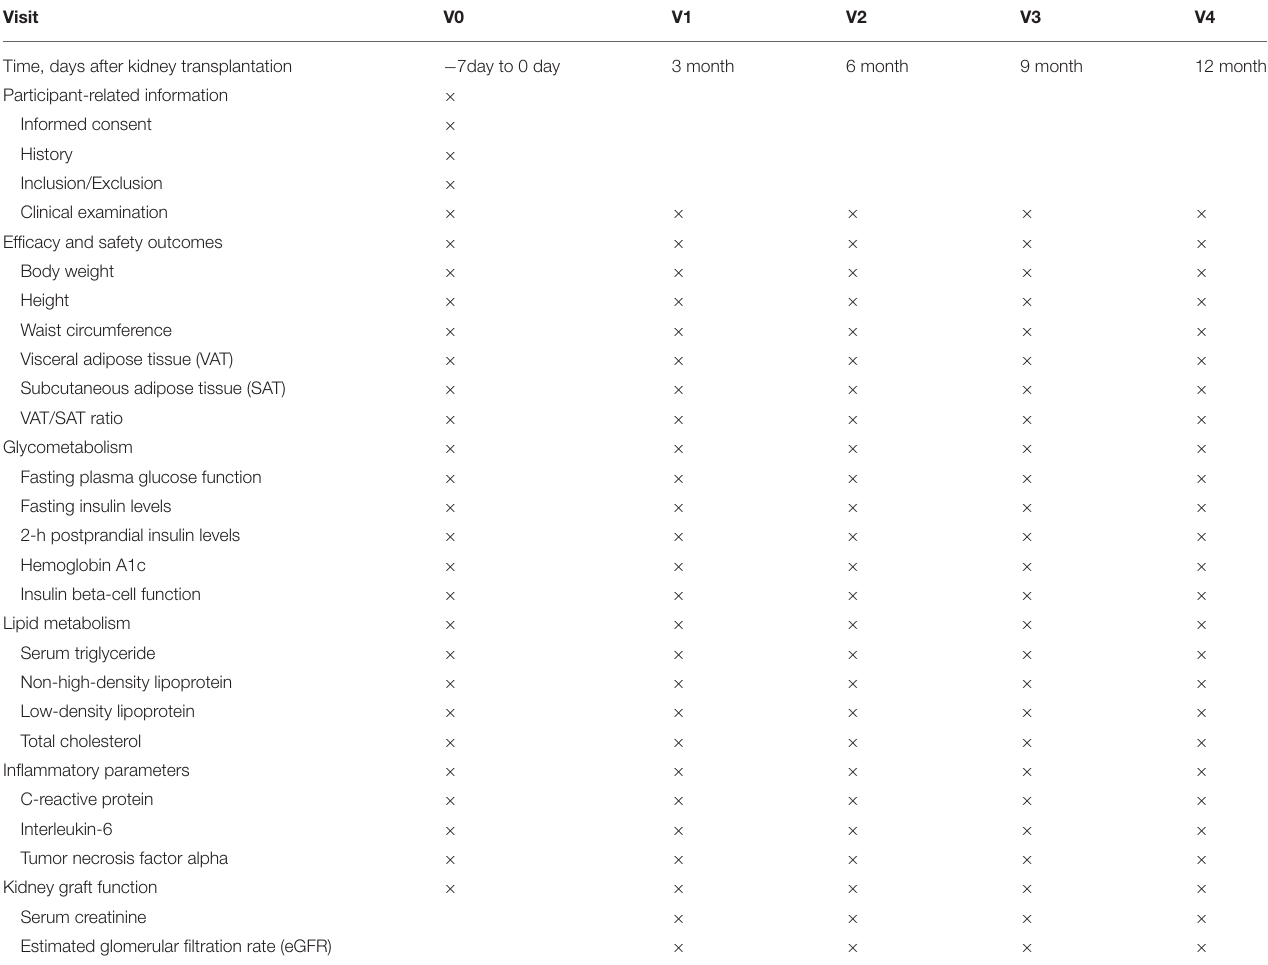
TABLE 1 | Routine follow-up. Visit V0 V1 V2 V3 Time, days after kidney transplantation Participant-related information × Informed consent History Inclusion/Exclusion